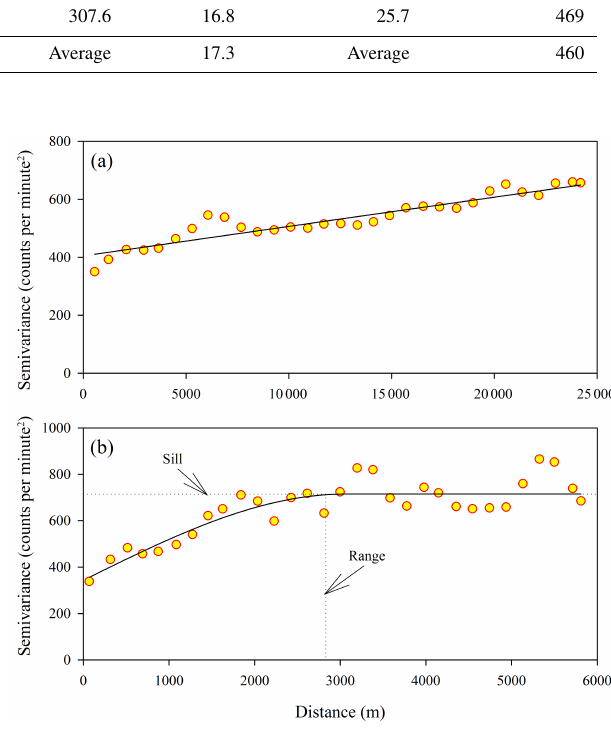
Figure 6. Example variograms used for block kriging for broad-scale and intensive surveys. The broad-scale variogram is from April 2016 (a) and the intensive-scale variogram is from June 2016 (b) . The sill and the range are shown in (b)